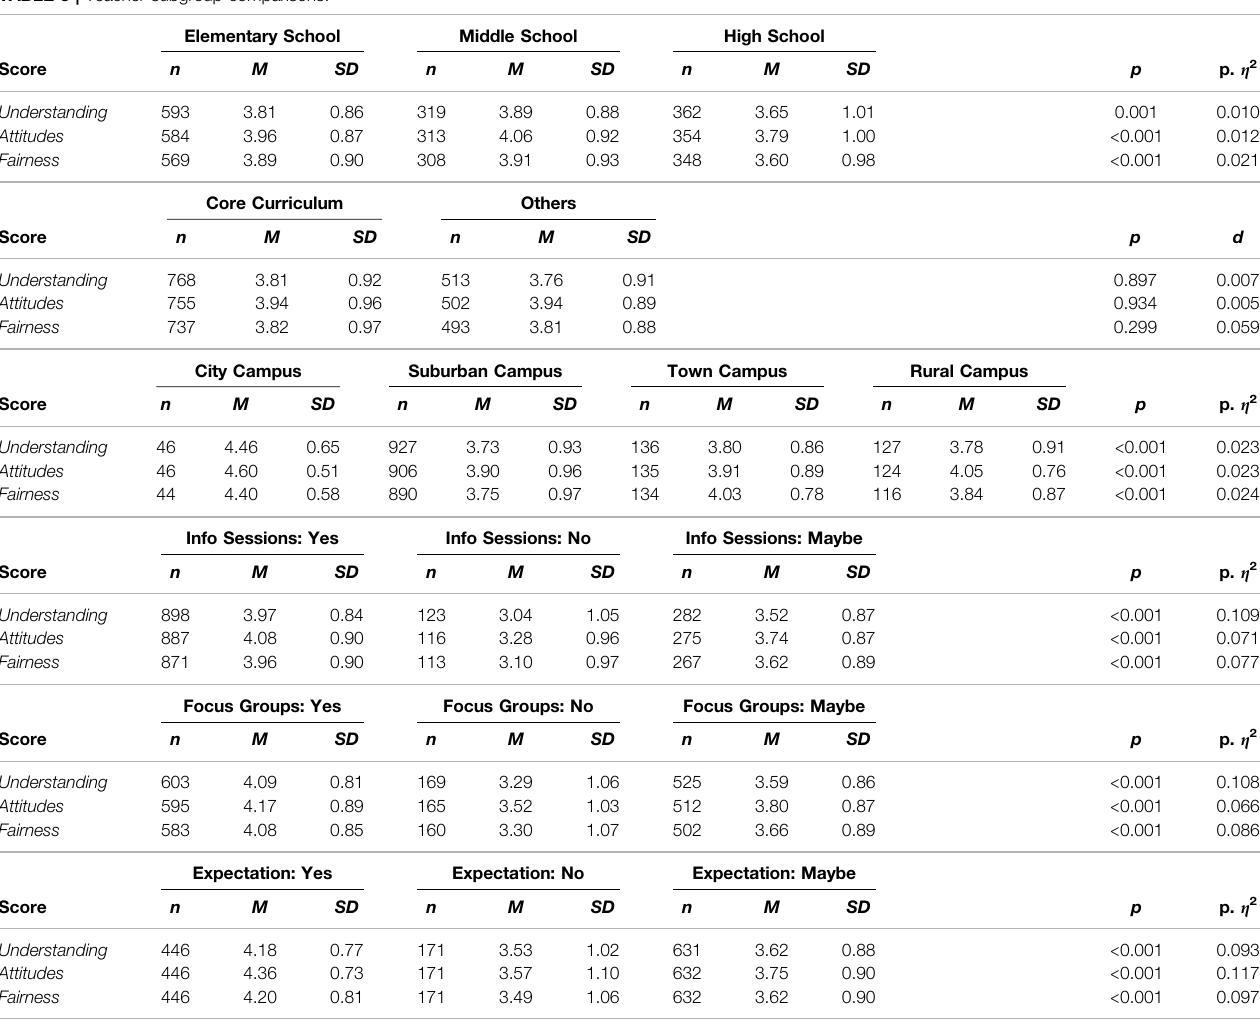
TABLE 3 | Teacher subgroup